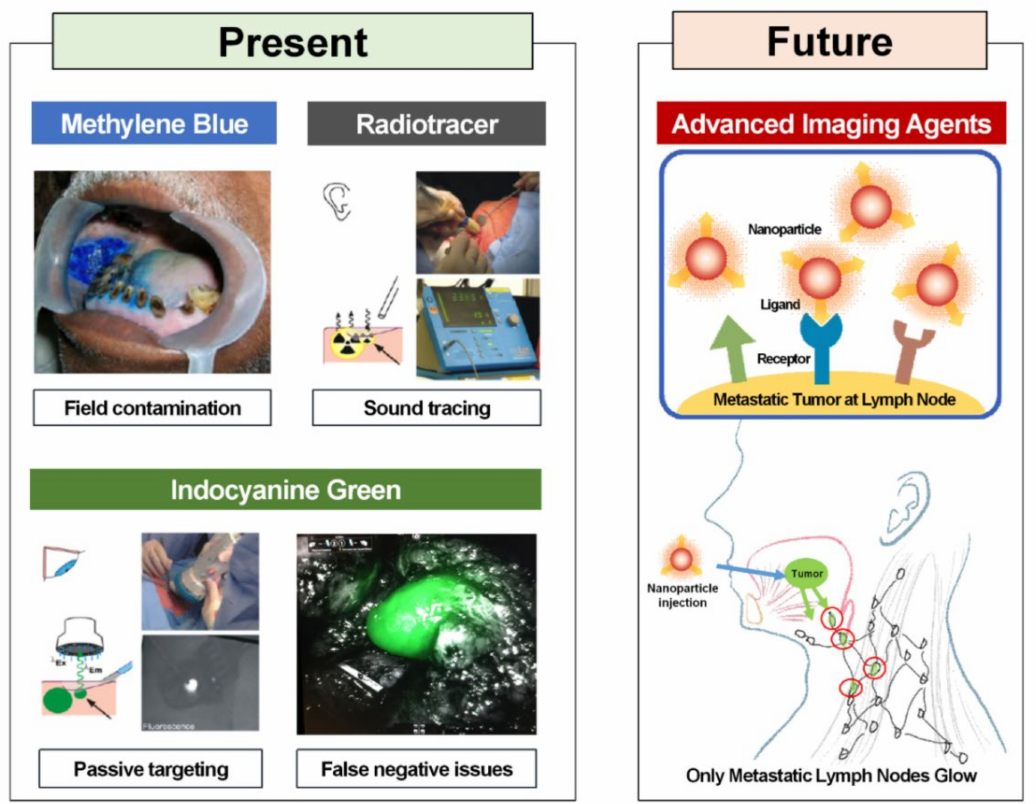
Figure 2. Present and future of sentinel lymph node biopsy surgical technics in oral cavity cancer. Reproduced from [72,91] with permission of Springer